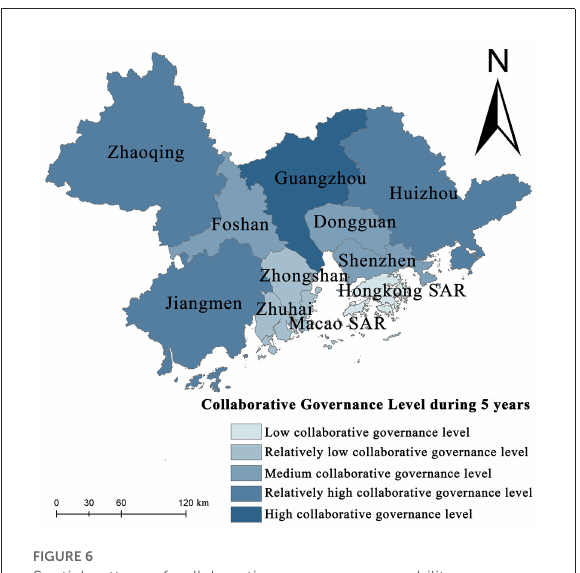
FIGURE6 Spatial pattern of collaborative governance